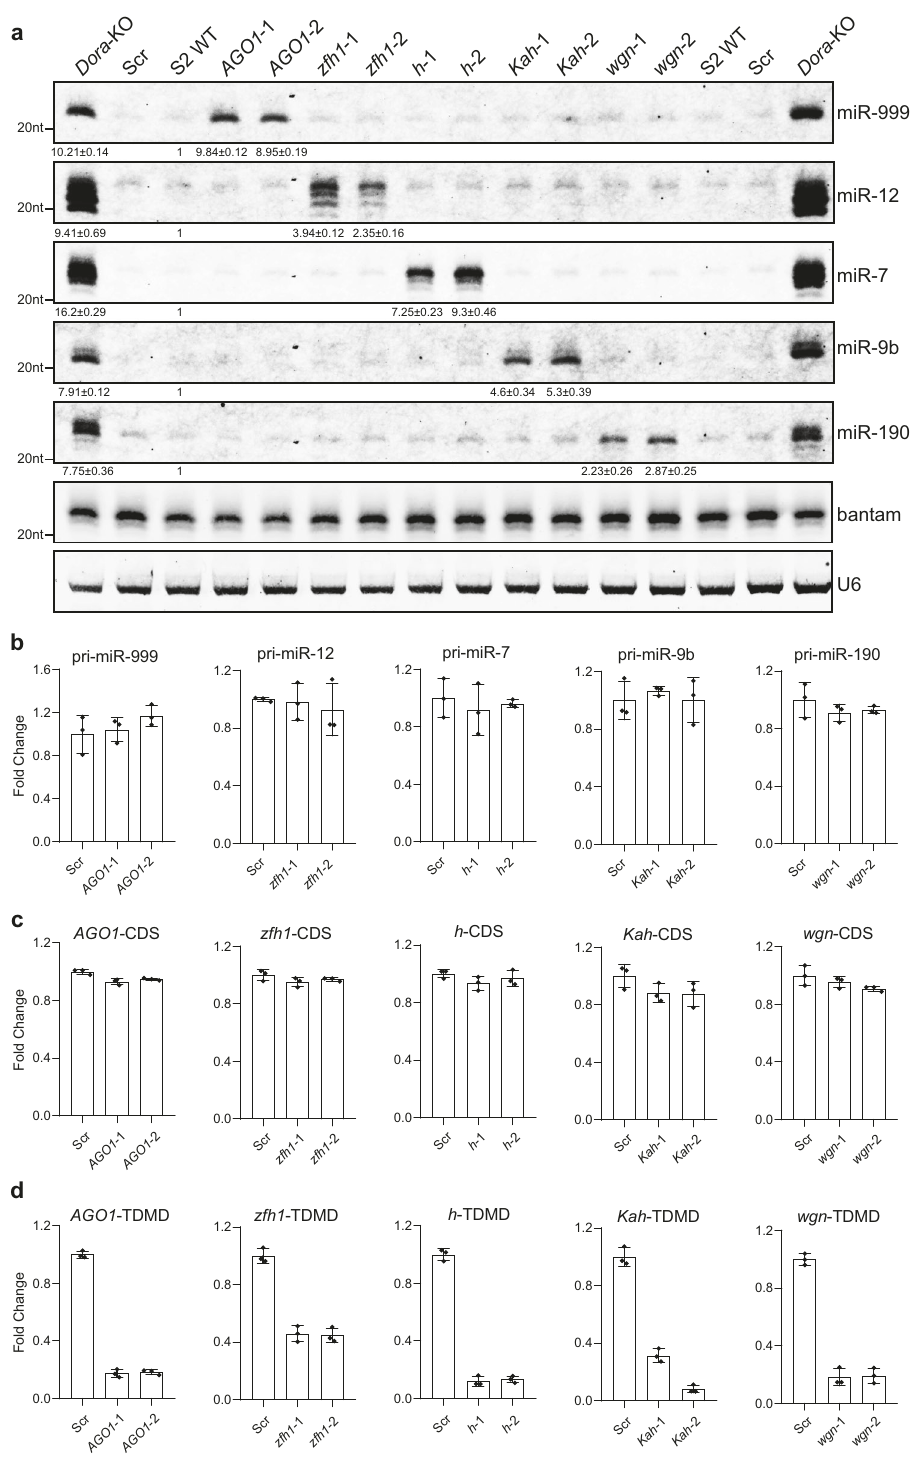
Fig. 3 | TDMD triggers knockout in S2 cells increase corresponding miRNAs. a Northern blotanalyses of miR-999, miR-12,miR-7, miR-9b, miR-190, bantam,and U6 in TDMD trigger knockout of AGO1 , zfh1 , h , Kah , wgn , and WT, control-KO (Scramble), Dora -KO S2 cells. Total RNAs were extracted from each trigger knockoutpopulationcellsselectedwith5 μ g/mLpuromycinfor4weeks.Thelevels of bantam and U6 serve as loading controls. The miRNA abundance normalized to